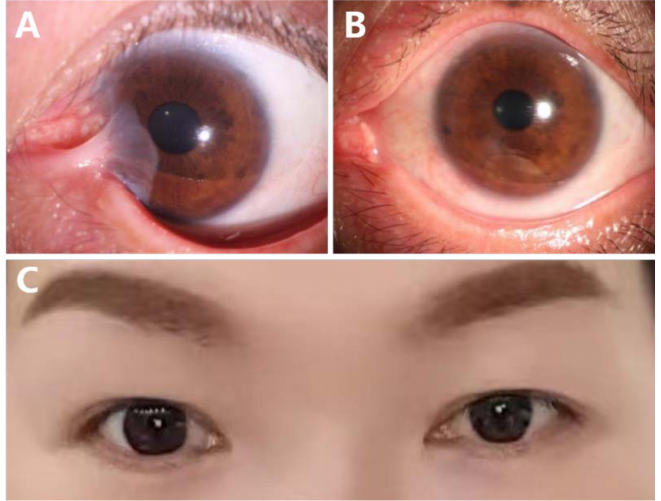
Figure 2. Case 2. The 36-year-old lady has recurrent pterygium, symblepharon, and limited abduction after four prior surgeries ( A ); No recurrence was observed after 36 months follow up with a silent ocular surface ( B ); Bilateral orthotropic and cosmetic appearance were restored ( C ).